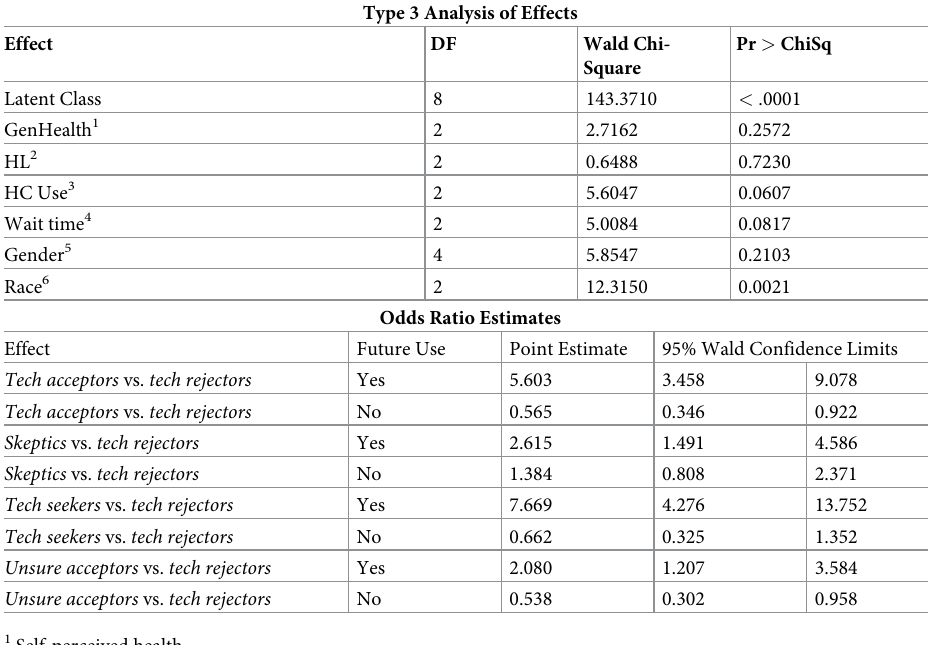
Table 6. Output for the five-class model with